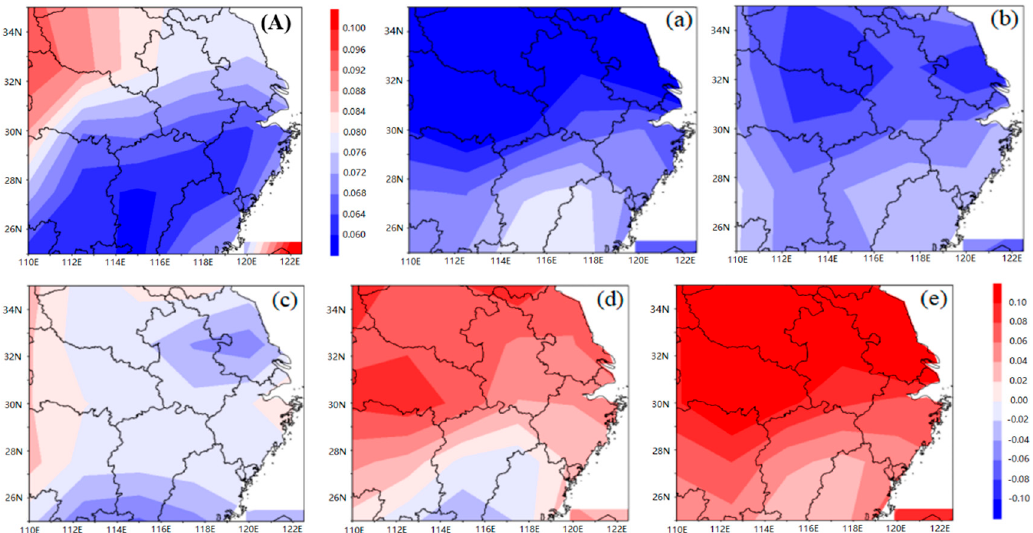
Figure 1. ( A ) Distribution chart of 35 years climatic mean for PRR during 1981 − 2015 in the MLRYR, ( a – e ) are the differences of PRR between ( a ) 1981–1995, ( b ) 1986–2000, ( c ) 1991 − 2005, ( d ) 1996–2010, ( e ) 2001–2015 and ( A ) 1981–2015. ( a – e ) is a slide average of the PRR in the MLRYR, as can be seen from ( a , b ), the PRR is significantly less than the average, and the degree of the water vapor is gradually increasing from south to north; from ( c , d ), the PRR is significantly higher than the average, and the degree of increase from south to north gradually increases. It is obvious from Figure 1 that the PRR in the MLRYR has increased markedly in the last 35 years, and the fastest increase is in the northern MLRYR region.